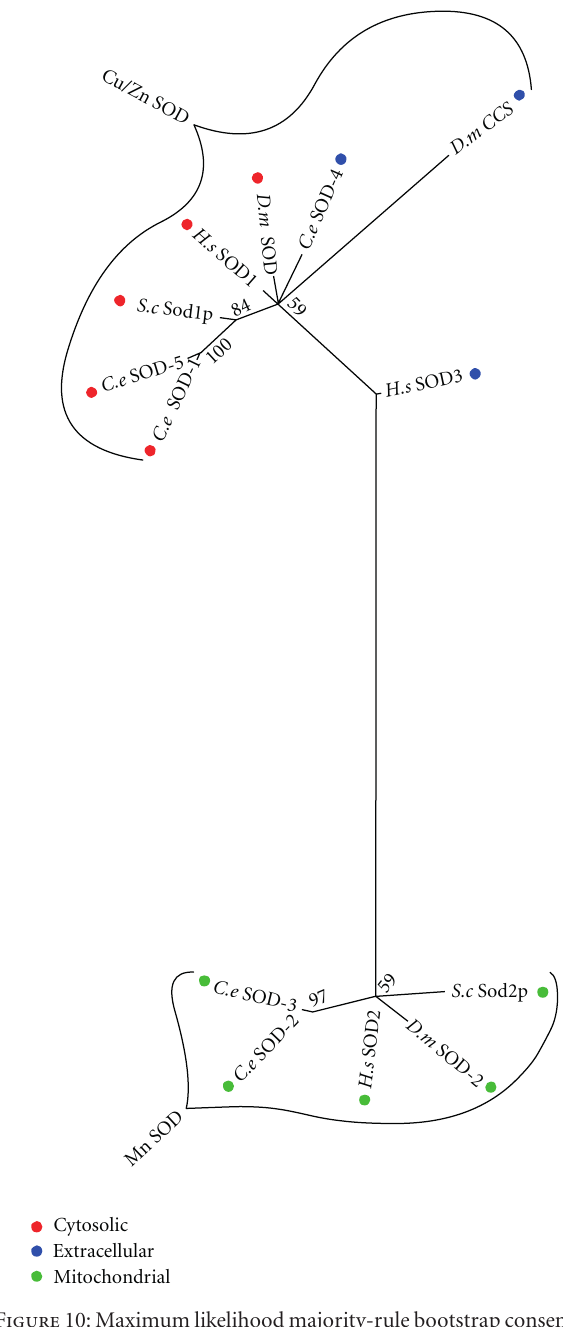
Figure 10: Maximum likelihood majority-rule bootstrap consensus tree of superoxide dismutase (SOD) proteins. See Figure 5 for details of how the sequences were identified and processed as well as how the phylogenetic analysis was carried